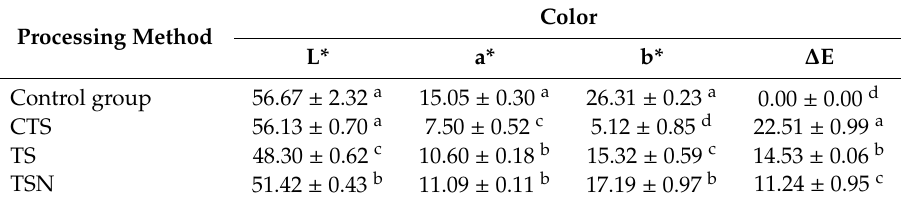
Table 1. Color parameters changes of grape juice after different sterilization treatments.